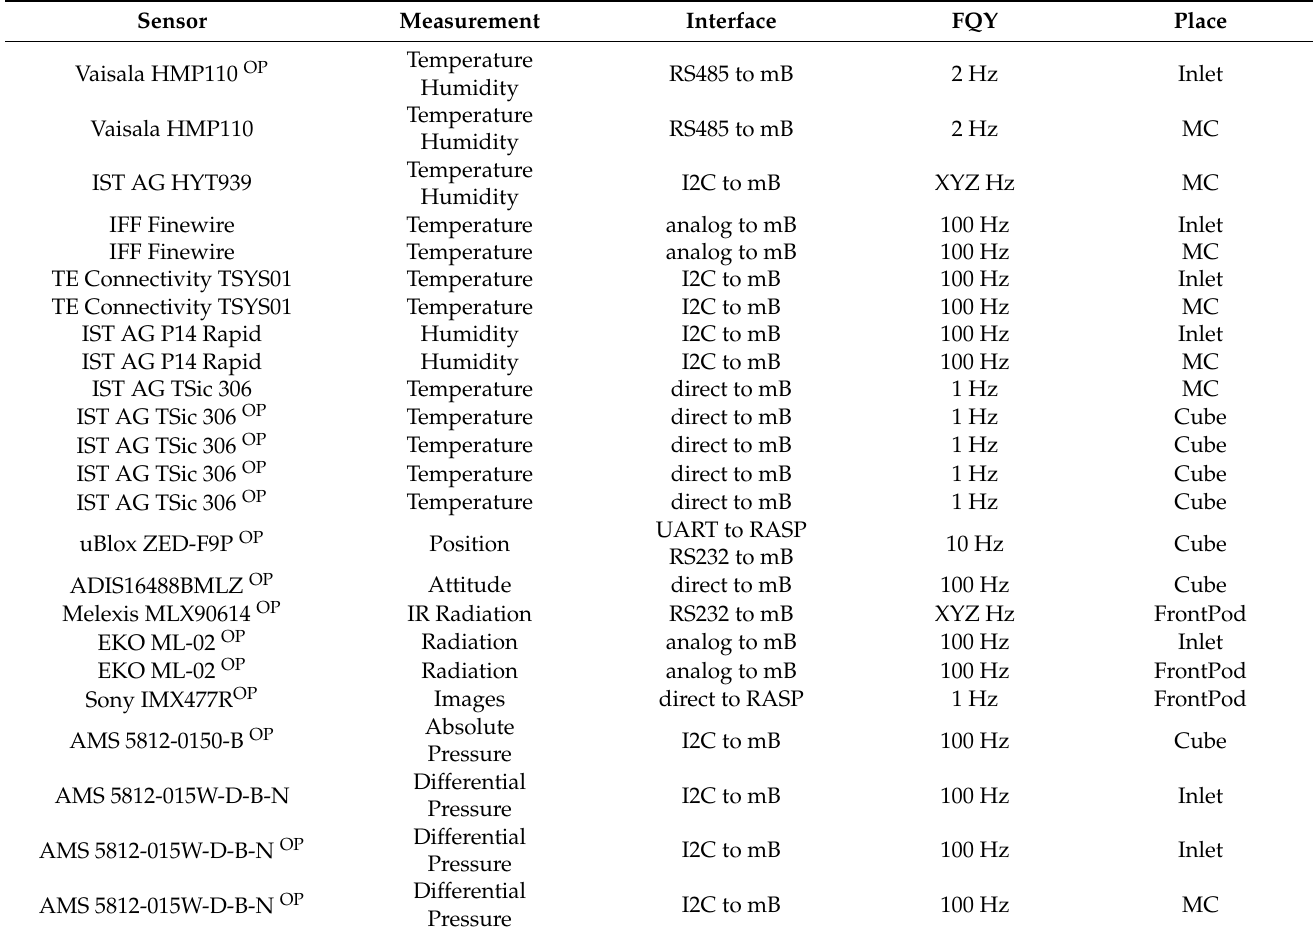
Table 1. Table list of meteorological